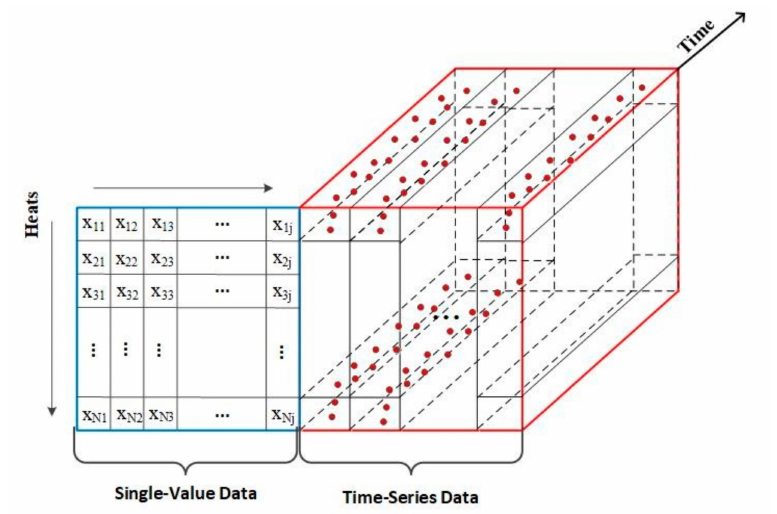
Figure 3. Technical parameters for converter